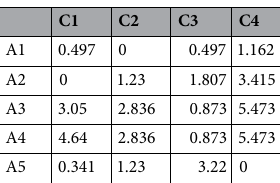
Table 7. The Truth-membership IC.